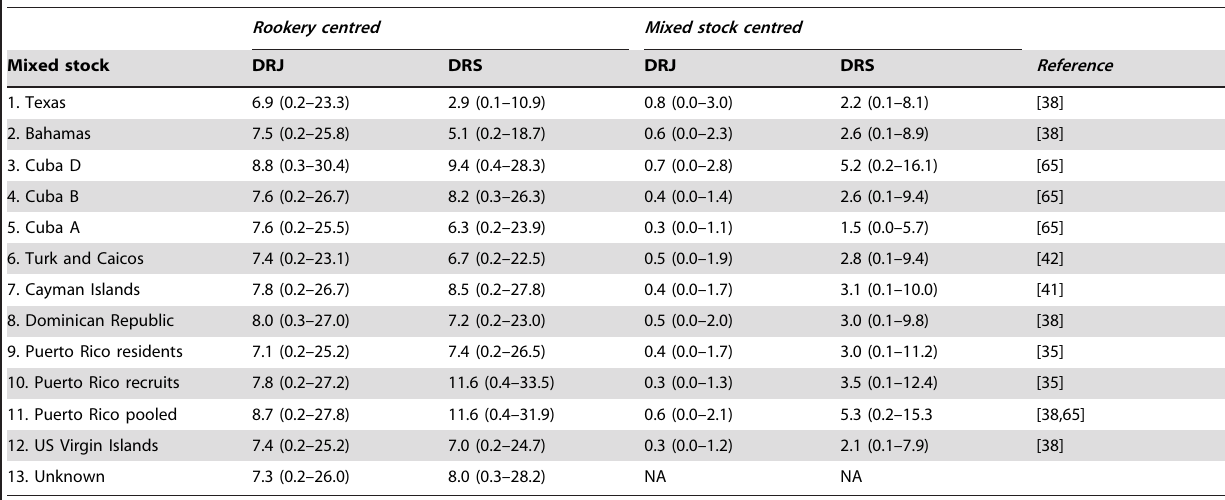
Table 4. ‘Many to many’ mixed stock analysis